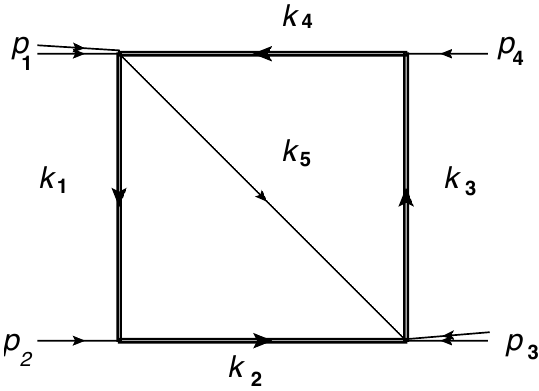
Figure 13 . The two-loop diagonal box with two o(cid:11)-shell legs. Thick double lines denote massive